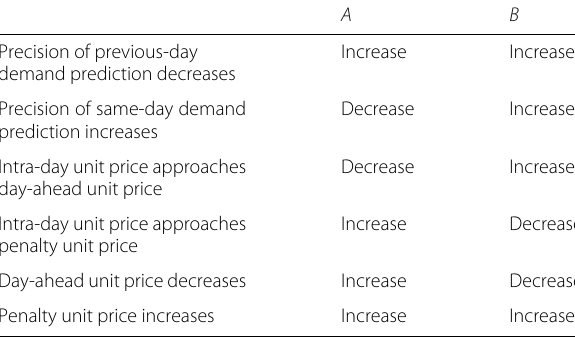
A B Increase Increase Decrease Increase Decrease Increase Increase Decrease